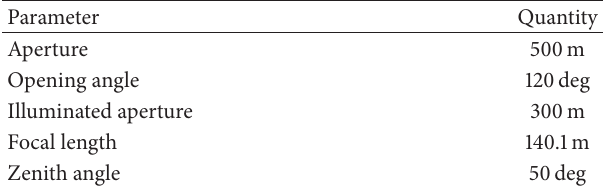
Table 1: Performance specifications for FAST.